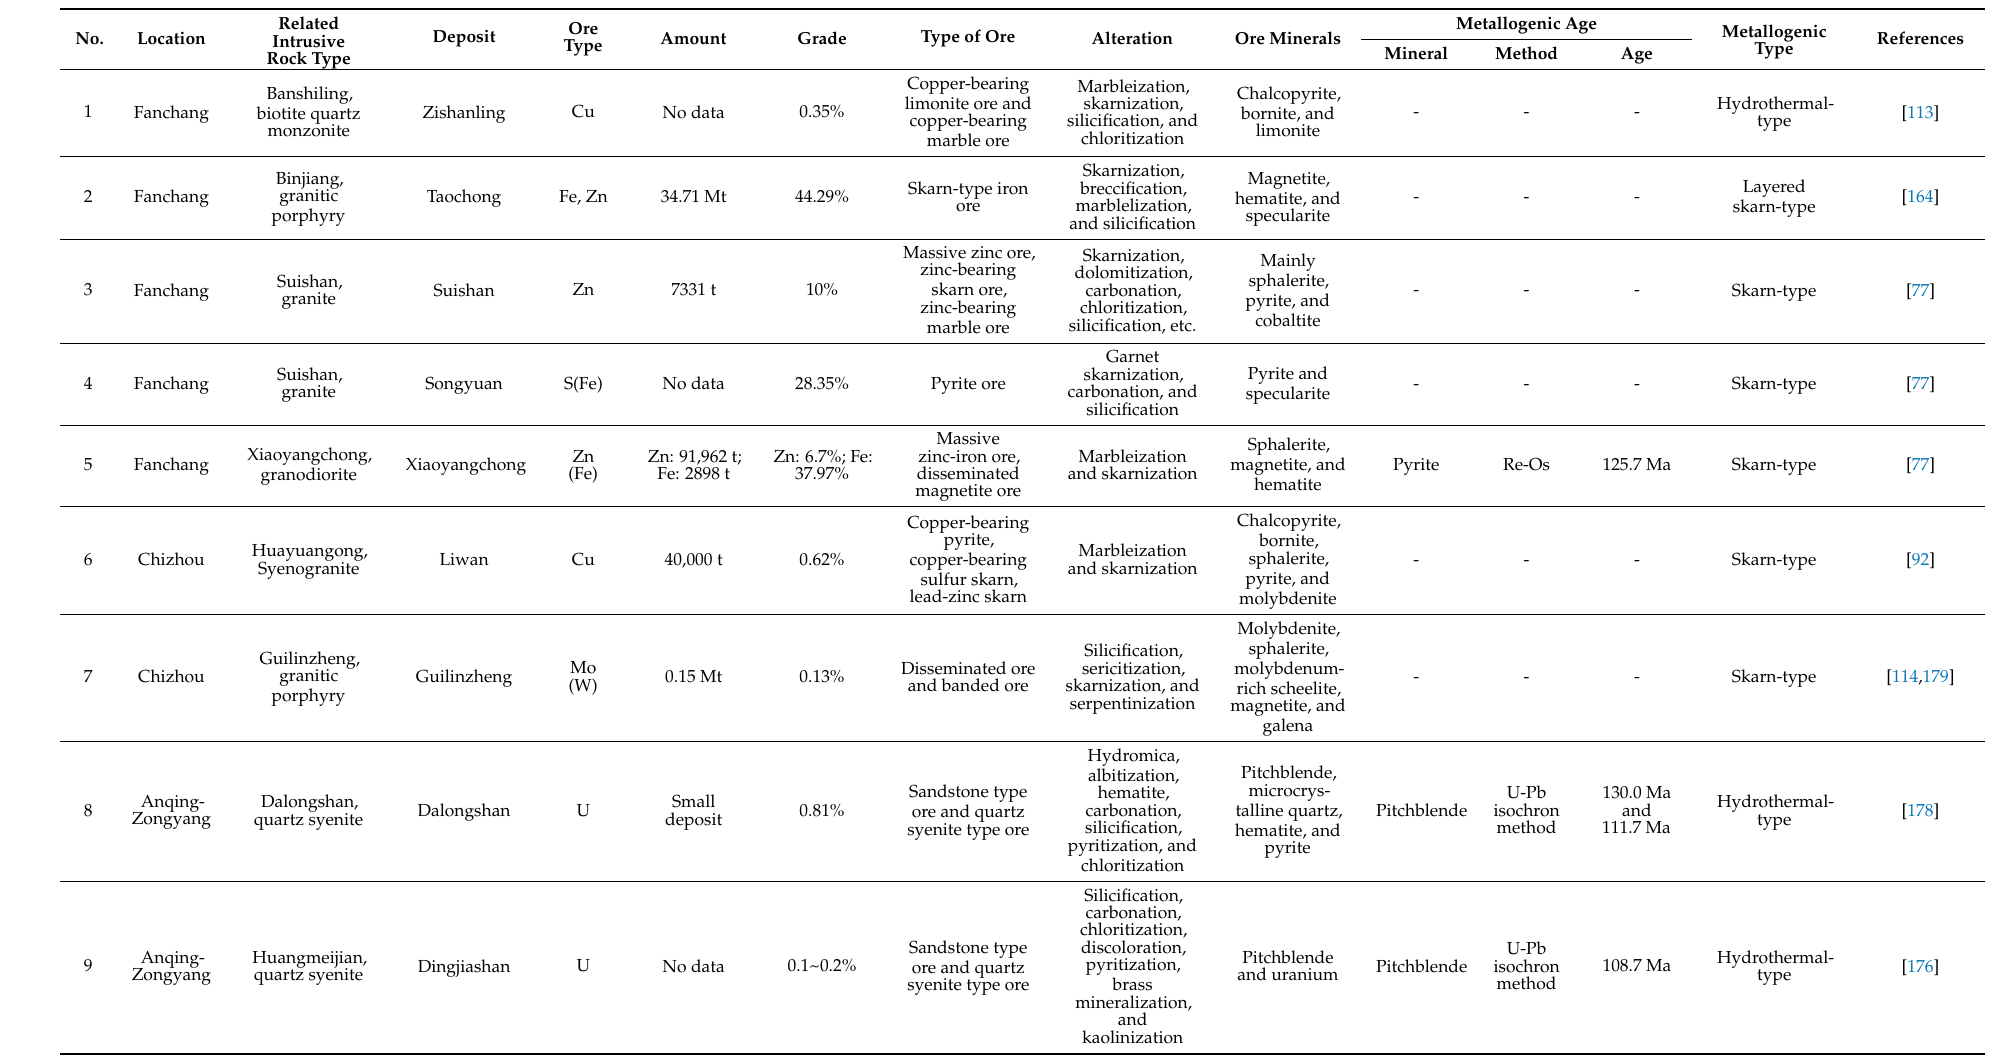
Table 2. Summary of deposits related to A-type granites in the